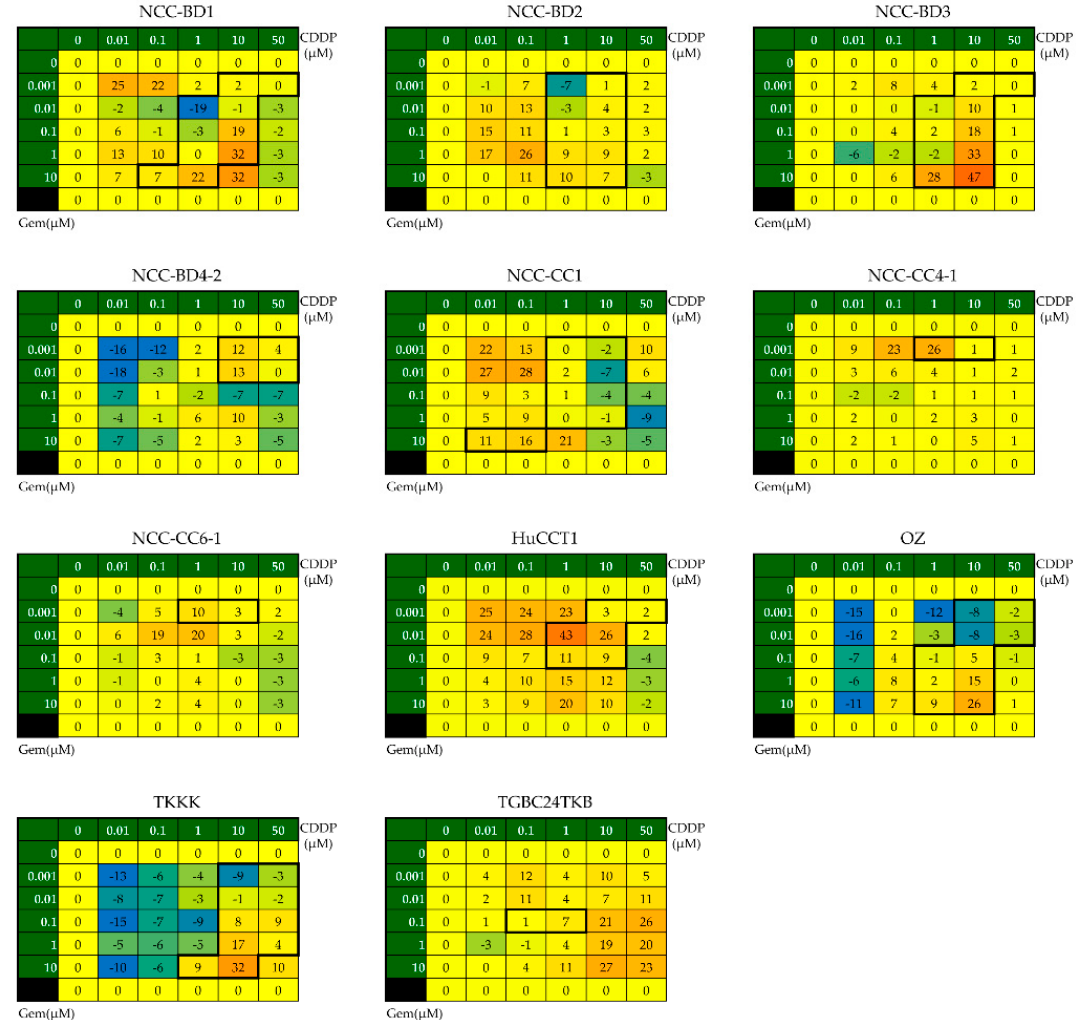
Figure 2. Evaluation of the combined effects of GC administration using the Bliss additivism model (BM). We determined the BM matrices to evaluate synergistic effects, focusing on the concentration ranges for which IC50 for CDDP was calculable. These concentration ranges are enclosed in the black frames on the heat maps of the BM matrices for each cell line. The mean value of the sum of the data for each cell in the matrices was calculated; a value of >1 was designated as BM positive (i.e., there was a synergistic effect).